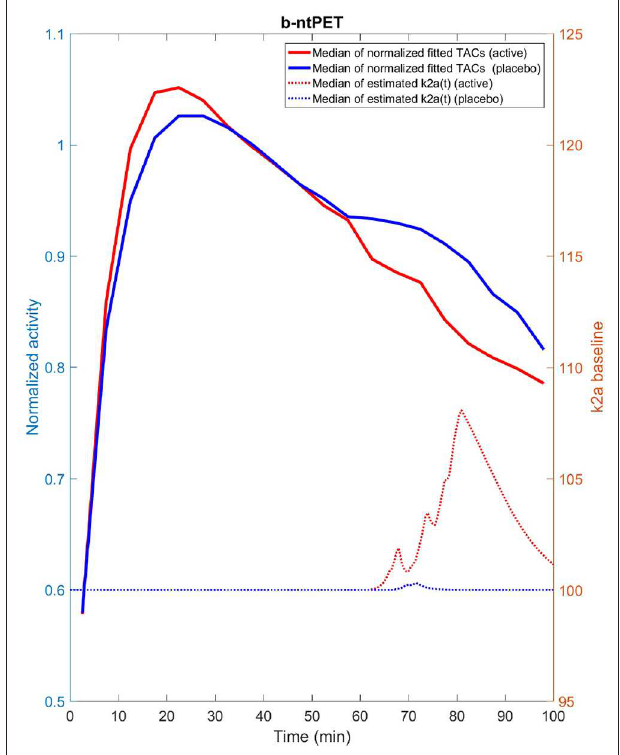
FIGURE 15 | Median estimated TAC fit (solid line) as well as median estimated endogenous releases (dash line) computed for the placebo (blue) and active (red) groups from the experimental [ 11 C]Raclopride study and using the multivariate HPD in lieu of the univariate HPD. We can note that the estimated releases produced with the multivariate HPD exhibit more acceptable and expected features than when the univariate HPD was used ( Figure 14 right) with a quasi null release for the placebo group and a more continuous release starting after the beginning of the stimulation for the active